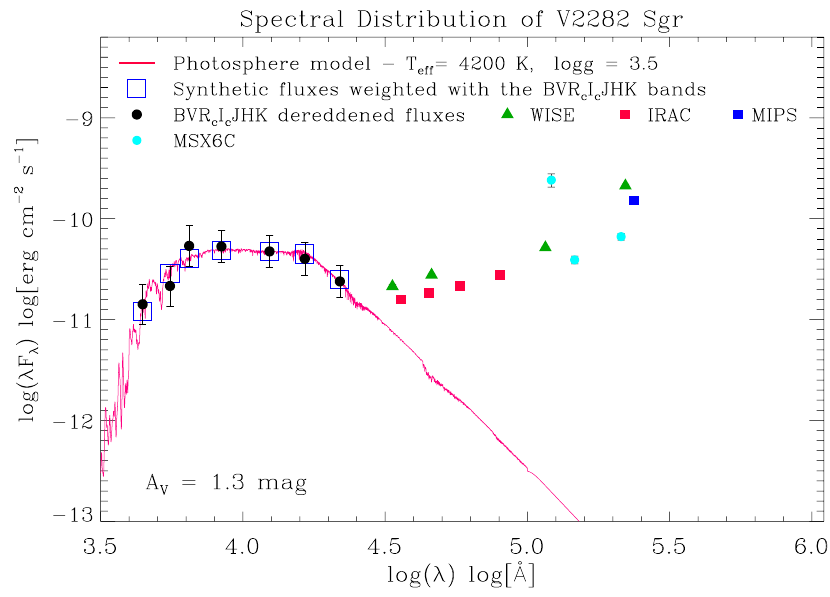
Figure 4: SED of V2282 Sgr from photometric de-reddened ( A V = 1.3 mag) data. The best-fitting NextGen synthetic spectrum with T=4200 K and log g = 3 . 5, is over-plotted with a continuous